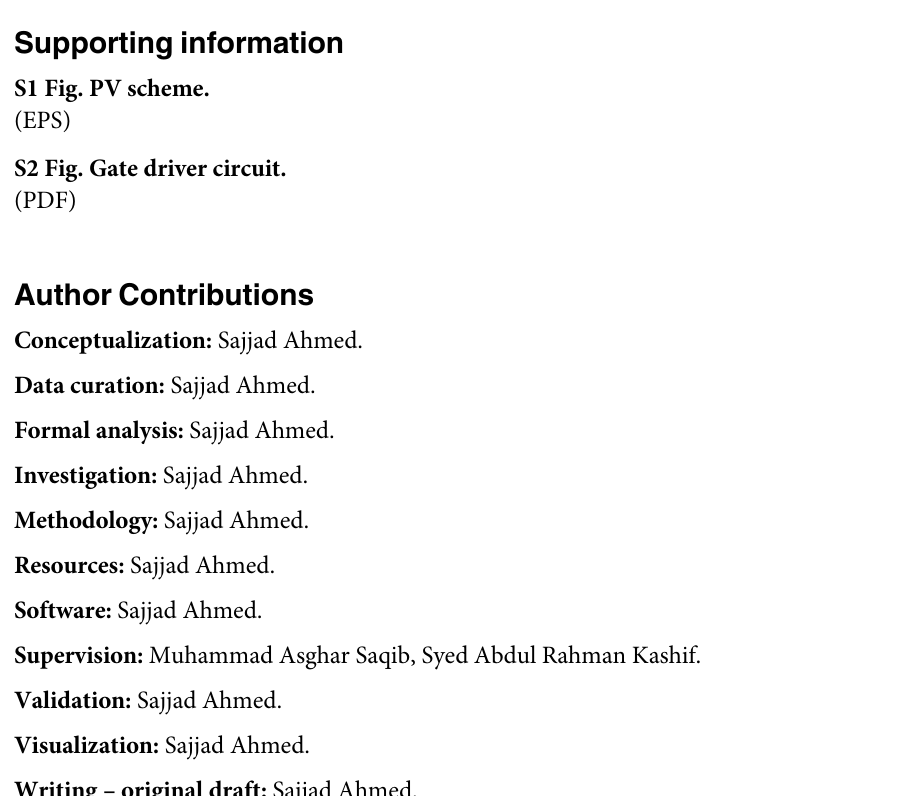
S1 Fig. PV scheme. S2 Fig. Gate driver